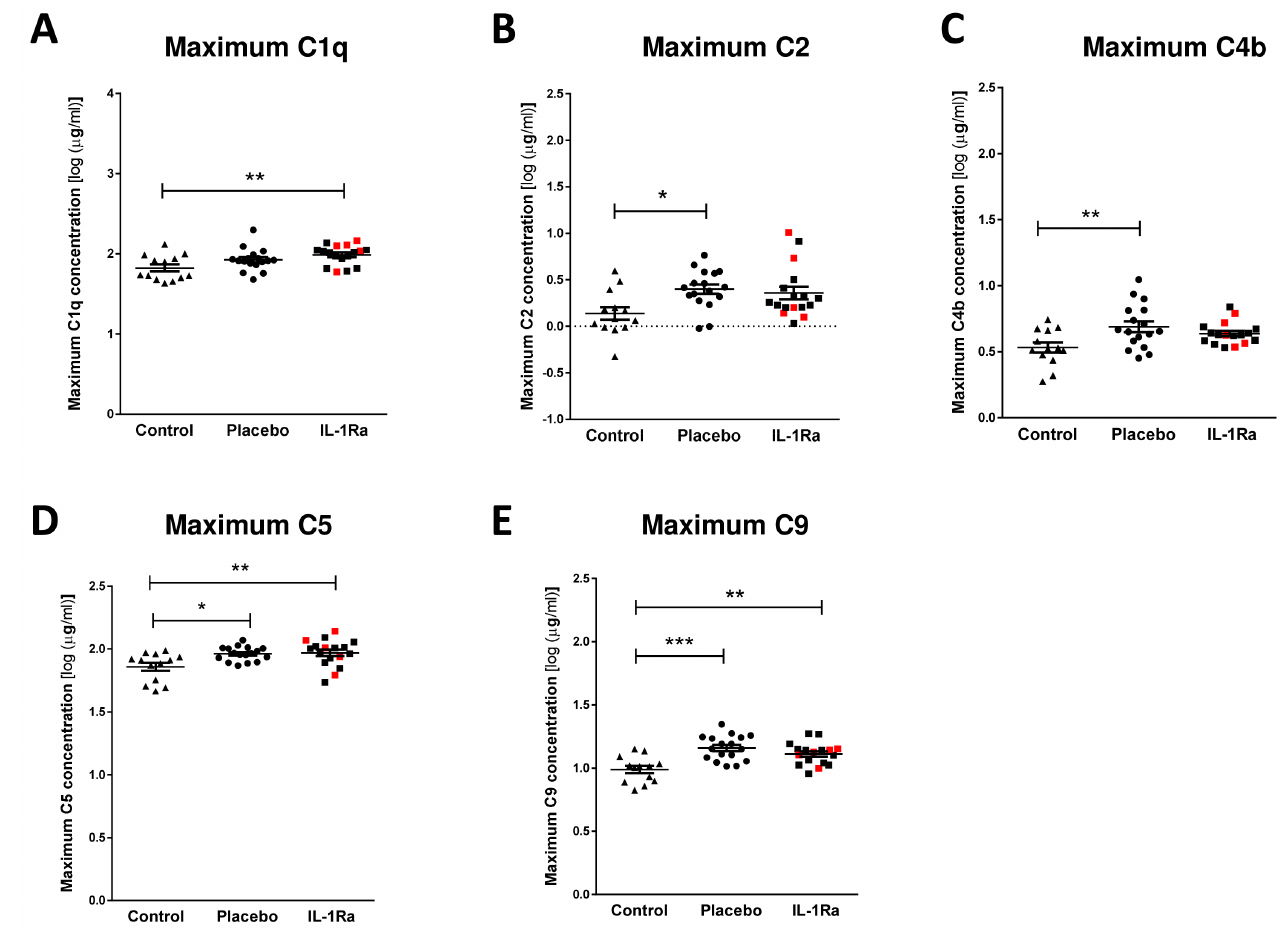
Figure 3. Treatment with IL-1 receptor antagonist (IL-1Ra) has no effect on complement components upregulated after stroke. Maximum concentrations of ( A ) C1q, ( B ) C2, ( C ) C4b, ( D ) C5 and ( E ) C9 were measured in the first seven days after stroke were increased in both placebo and IL-1Ra treated patients in comparison to healthy controls. Data show mean ±SD, * P<0.05 ; ** P<0.01 ; one-way ANOVA with Bonferonni